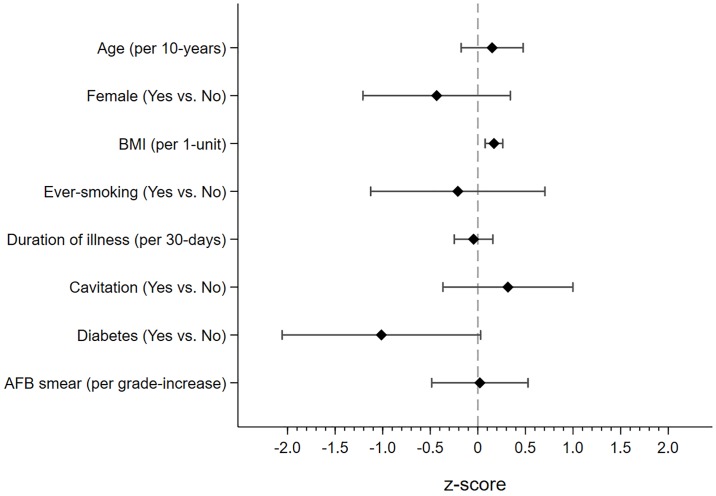
Difference in FVC z-score by participant characteristics at treatment initiation.Figure depicts point estimate and accompanying 95% confidence interval for FVC standardized by z-scores. Higher z-scores indicate better FVC. Regression analysis was adjusted for age, sex, BMI, ever-smoking, duration of illness, cavitation, diabetes and smear grade. FVC—forced expiratory volume, BMI—body mass index, AFB—acid fast bacilli.